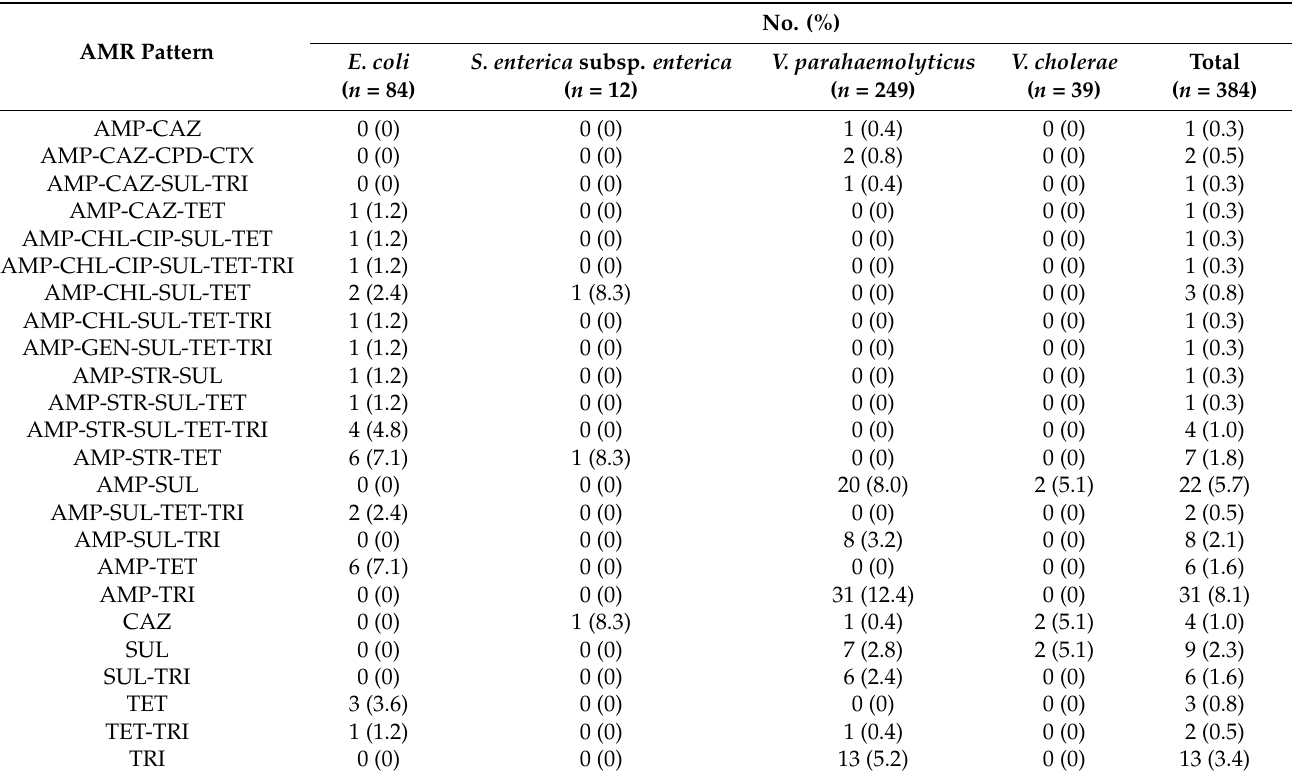
Table 2. Cont. Table 2. Phenotypic resistance patterns of E. coli , S. enterica subsp. enterica , V. parahaemolyticus ,